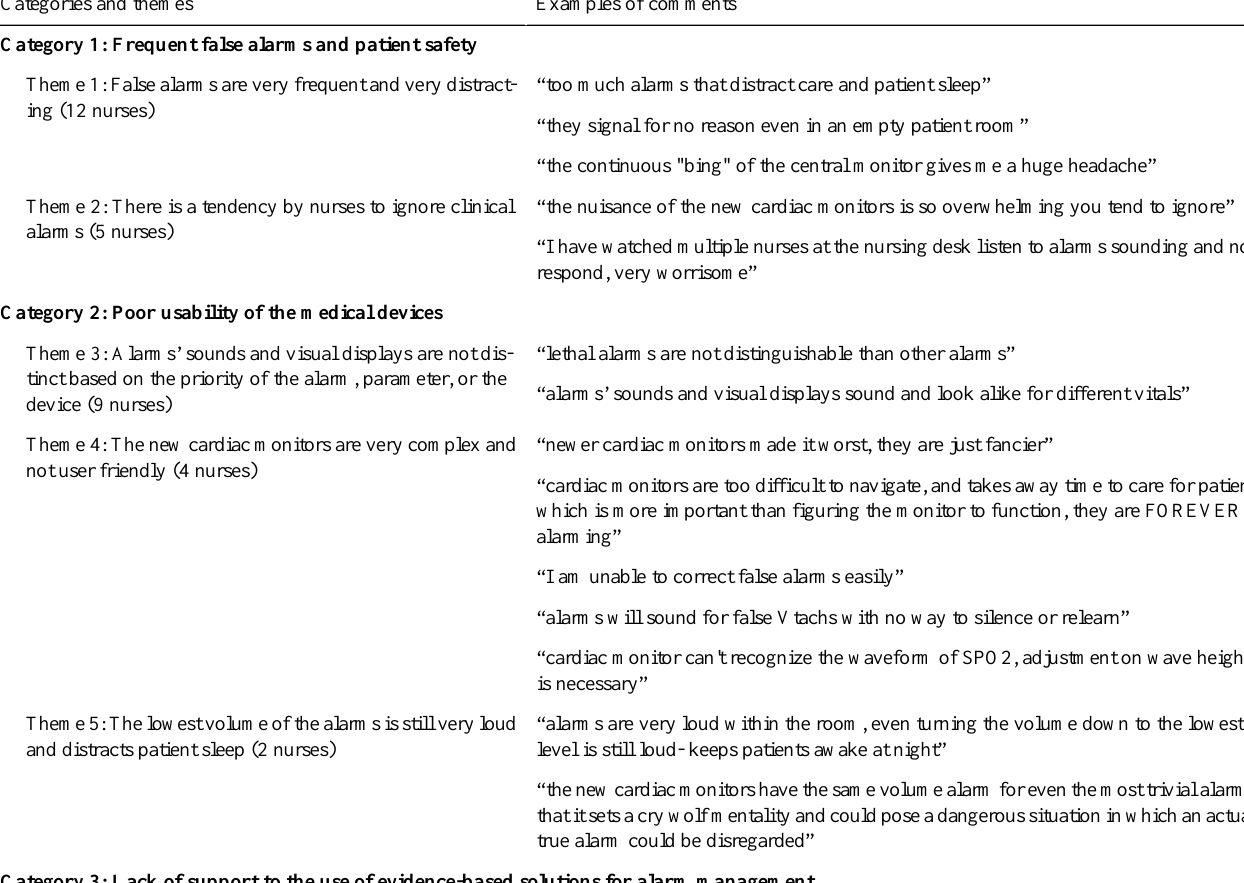
Table 2. Categories, themes, and comments of the TCICU nurses’narrative data (N=22).